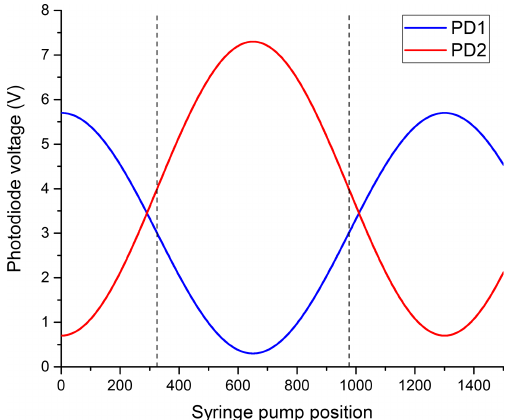
Figure 6. The interferometer scan of photodiode PD1 and PD2 volt- ages is performed by changing the optical path of one of the interfer- ometer arms using the pressure cell. A 1 λ difference in optical path corresponds to 1300 steps of the syringe pump. Quadrature points are marked by dashed